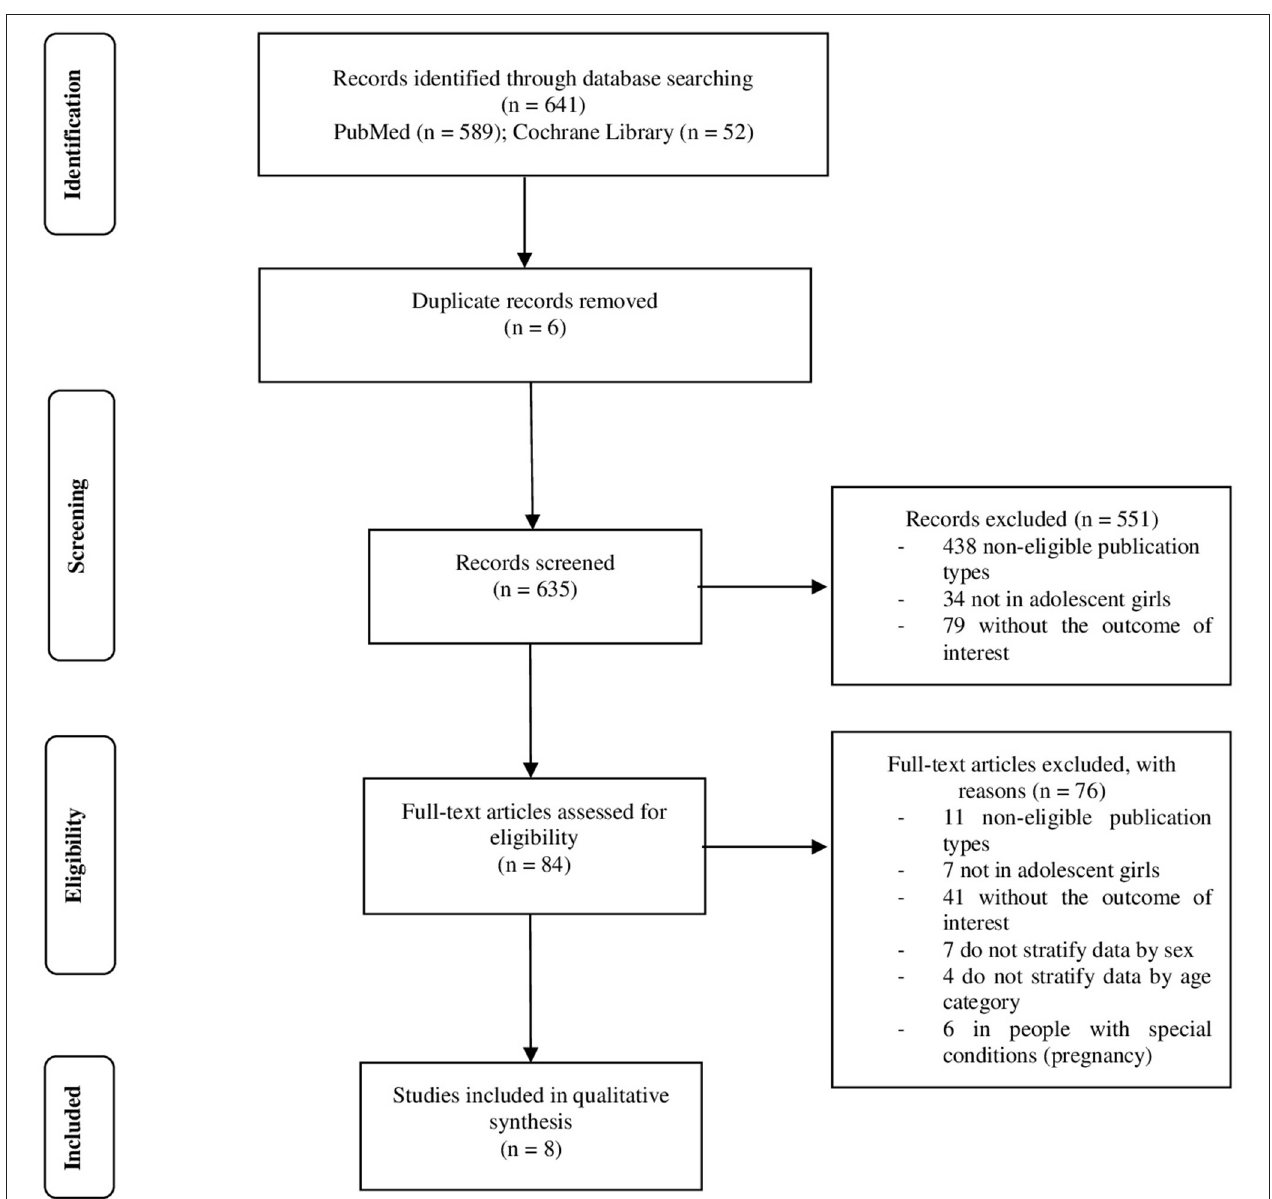
FIGURE 1 | Flow diagram of included